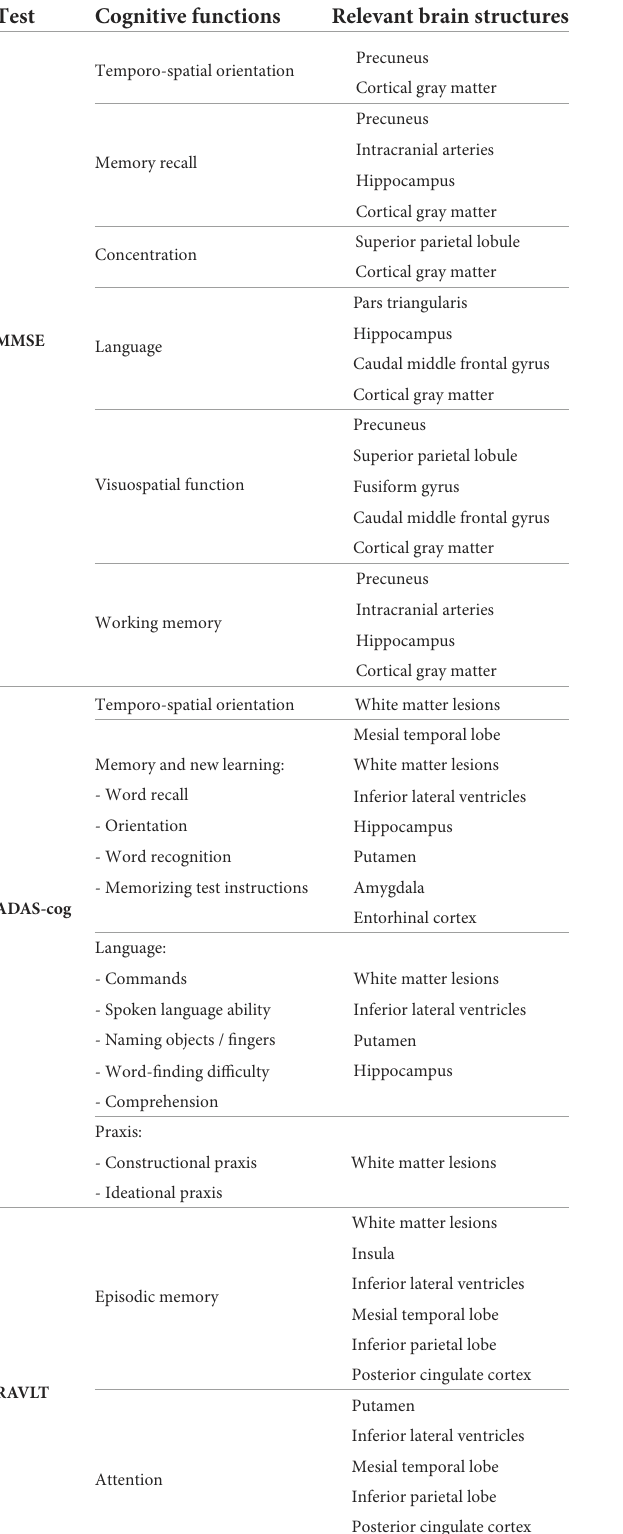
TABLE 6 Structural brain correlates and cognitive functions involved in DSST and